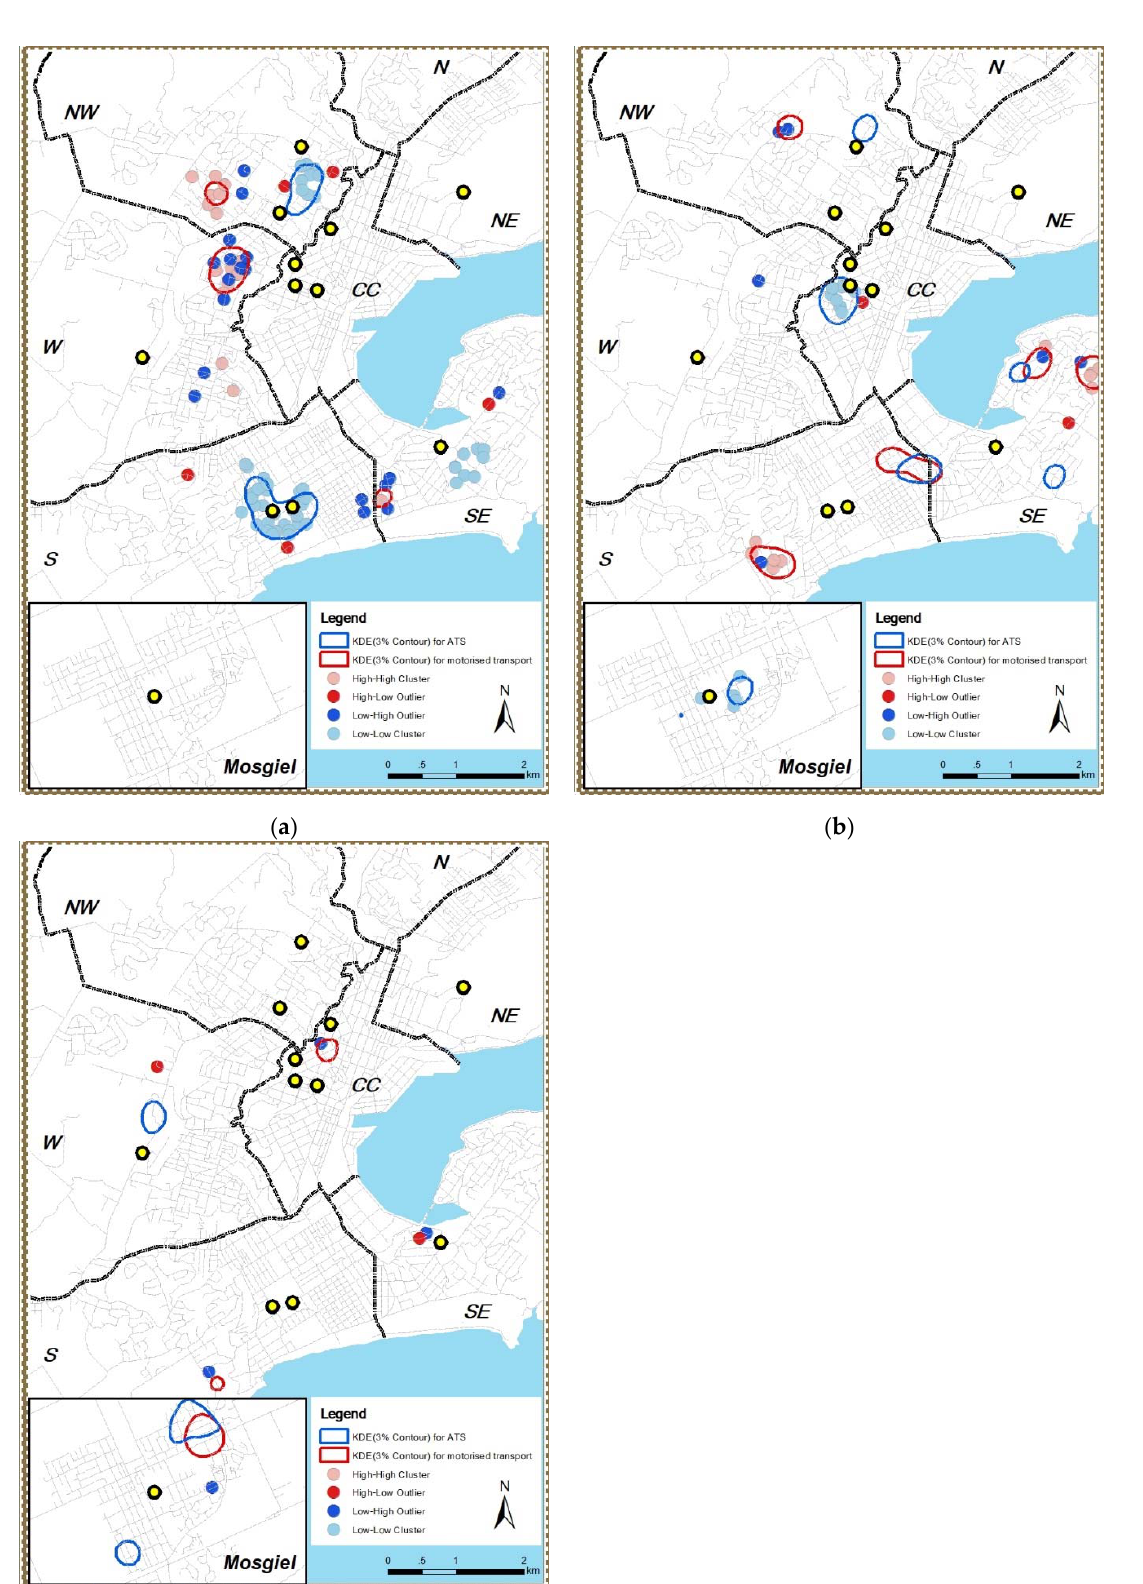
Figure 7. KDE and LISA transport modes distribution on mixed land use entropy: ( a ) low home neighbourhood mixed land use entropy; ( b ) medium home neighbourhood mixed land use entropy; ( c ) high home neighbourhood mixed land use entropy.